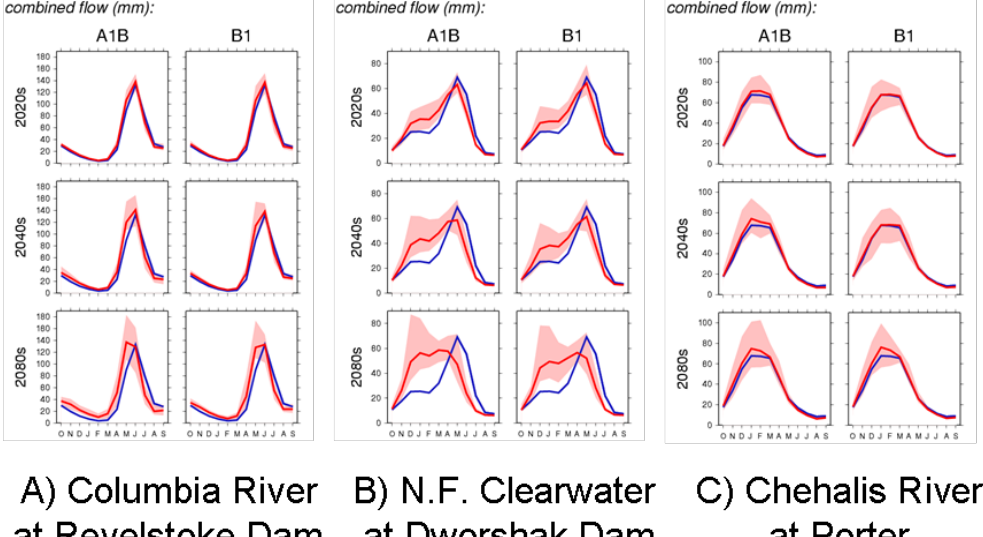
Fig. 4. Monthly average runoff simulations for three PNW watersheds for three future time periods and emissions scenarios, (A) the Columbia River at Revelstoke Dam, (B) the N. F. Clearwater at Dworshak Dam, (C) the Chehalis River at Porter. Blue lines show the monthly runoff for the 20th century climate (1916–2006), the pink bands show the range of the 10 hybrid delta climate change scenarios (based on the IPCC AR4), and the dark red line shows the average of the hybrid delta ensemble. Source: Columbia Basin Climate Change Scenarios Project: http://www.hydro.washington.edu/2860/